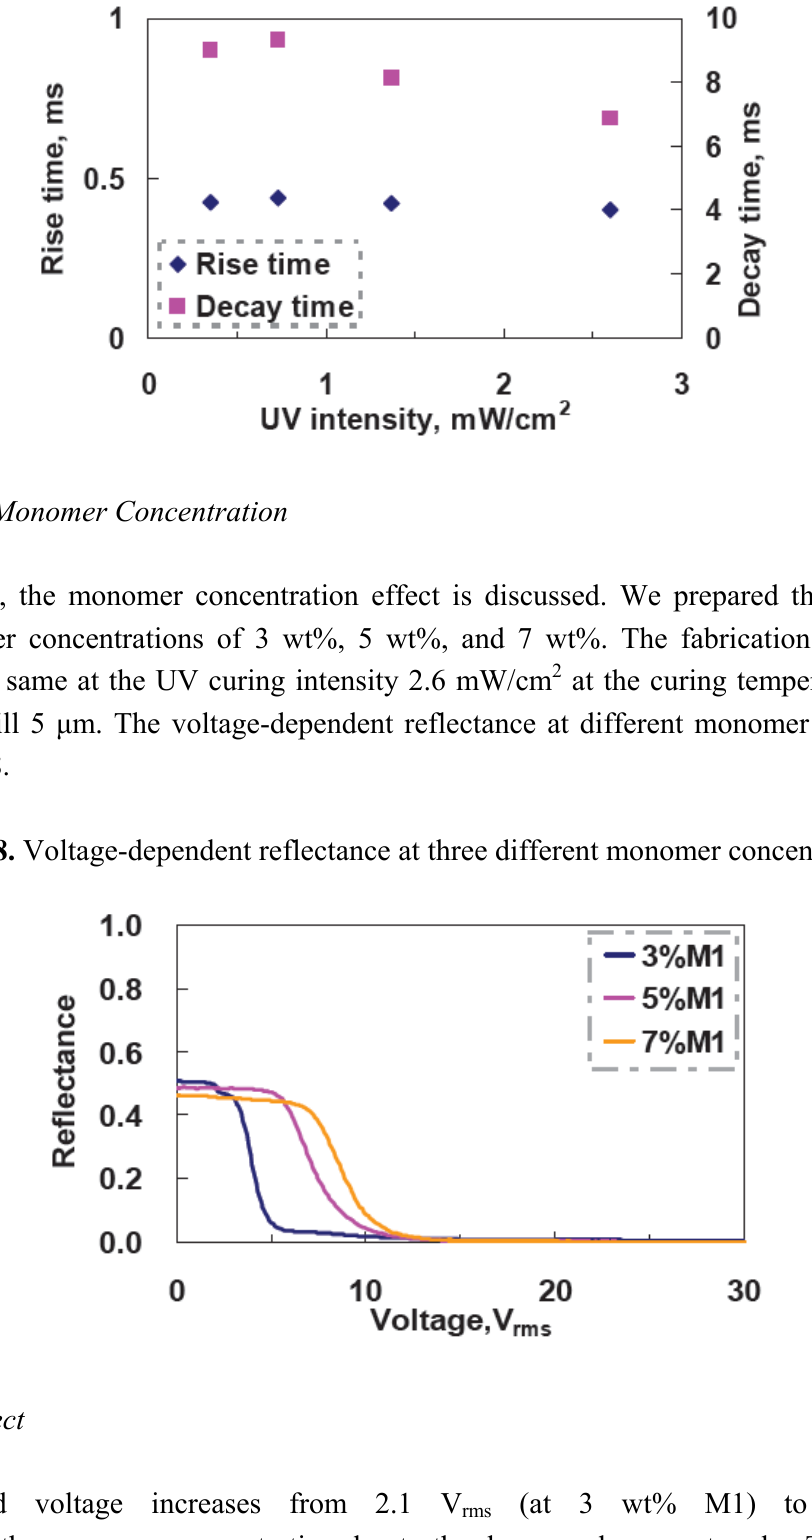
Figure 7. Measured response time as a function of UV curing intensity at a curing temperature of 10 °C.